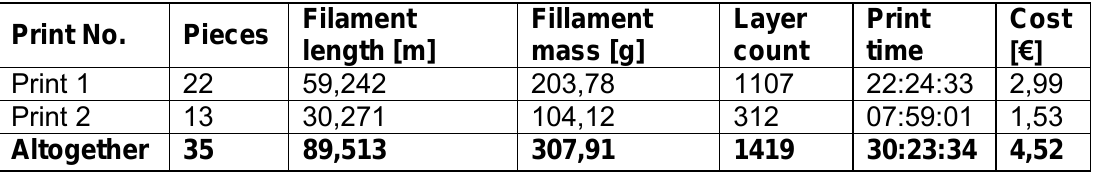
Table 2. Material